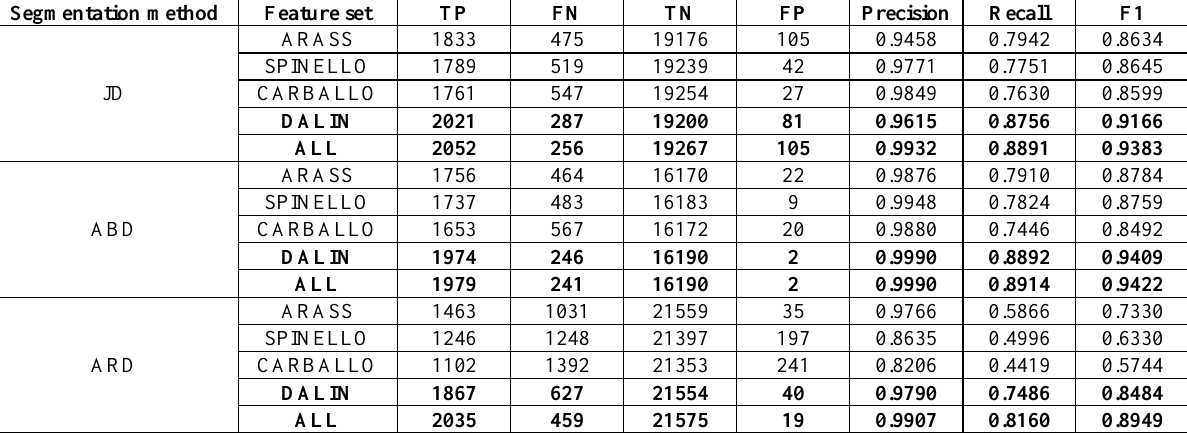
Table 8. Classification results of leg segments by different methods for data set HOME